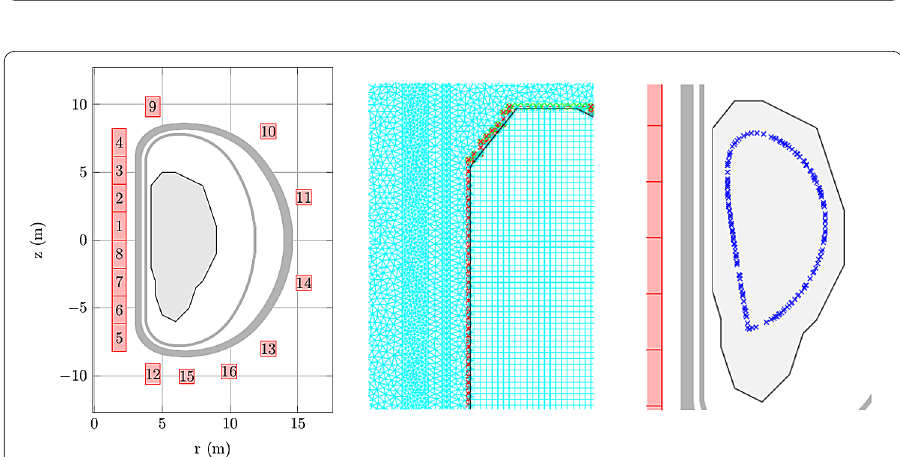
Figure 12 Tokamak CFETR. the geometry (left), a zoom of the composite meshes (center), and the location the points x i in the definition of the objective functional C 1 (right)